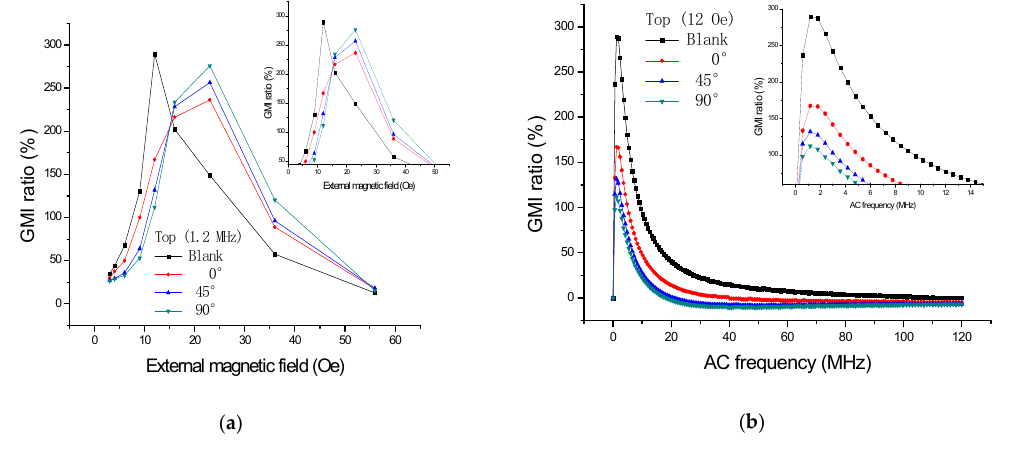
Figure 8. The giant magnetoimpedance responses when the ribbon (3 × 5 mm 2 ) is detected on the top of the giant magnetoimpedance sensor II with different angles (0°, 45°, 90°): ( a ) field dependence and ( b ) frequency dependence.